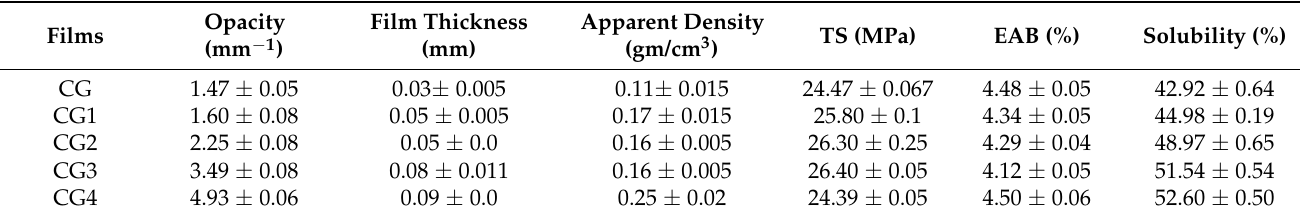
Table 2. Opacity, Film Thickness, Apparent Density, Tensile Strength (TS), Percentage of Elongation at Break (EAB %), Solubility. Mean values and standard deviation are